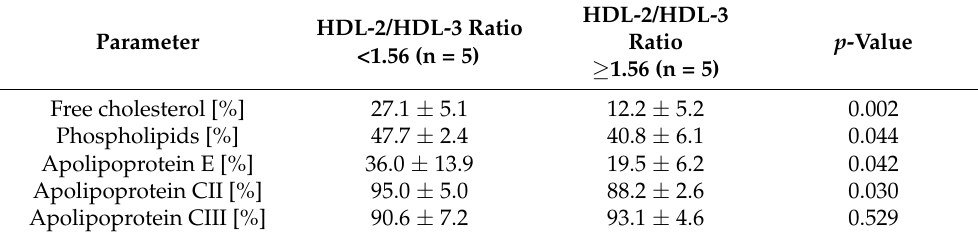
Table 2. Percentage [%] of surface lipids and apolipoproteins released from VLDL during lipolysis in the presence of HDL T depending on the HDL-2 / HDL-3 cholesterol ratio. Value of 1.56 is a median of HDL-2 / HDL-3 cholesterol ratio calculated for study group. Data are presented as mean ± SD.